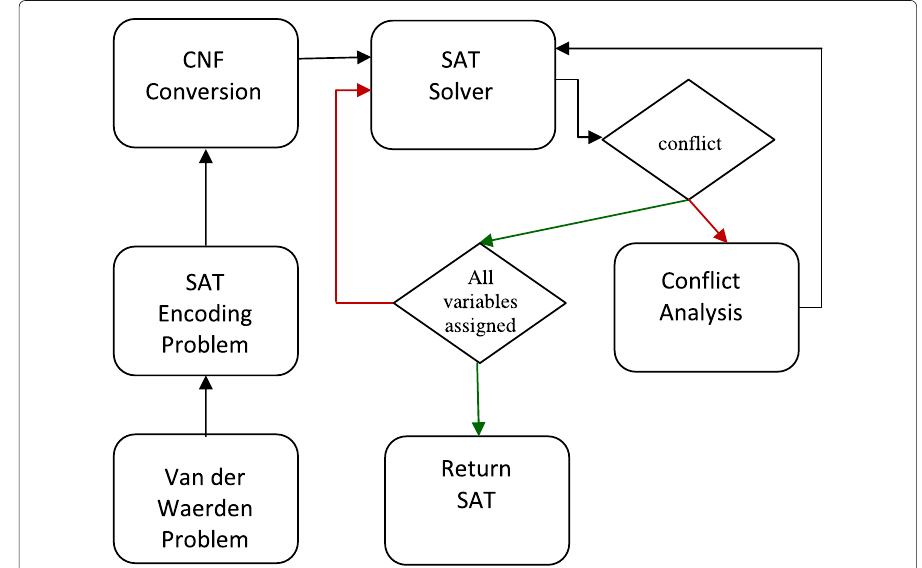
Fig. 1 Converting Van der Waerden number problem into